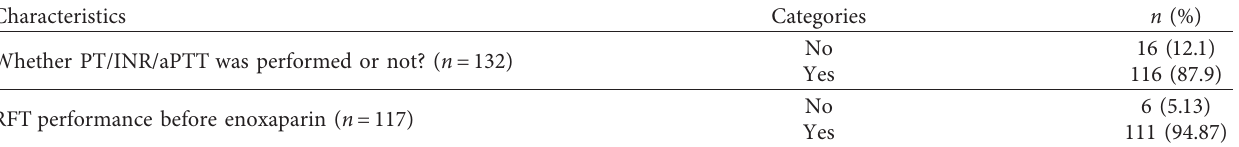
Table 3: PT/INR/aPTT test and renal function test performance before enoxaparin Characteristics